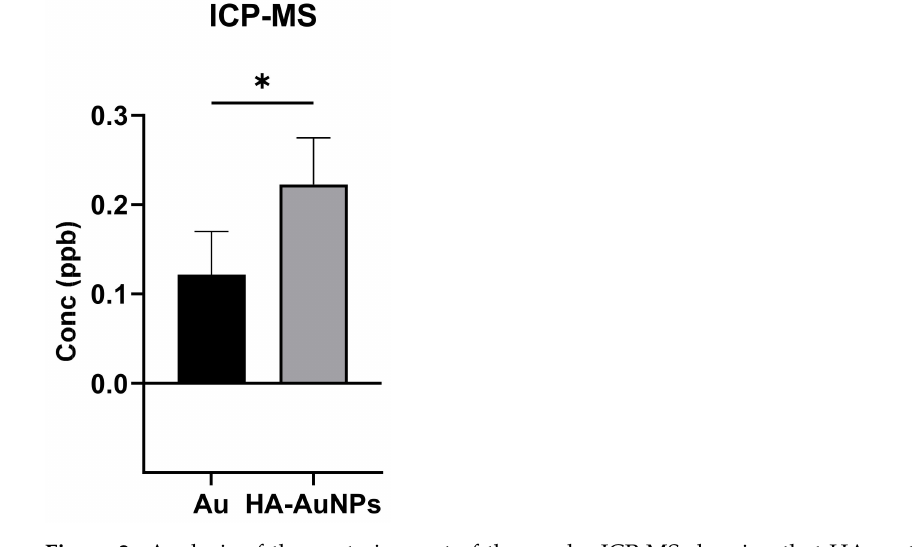
Figure 2. Analysis of the posterior part of the eye by ICP-MS showing that HA coating indeed improves NPs distribution. Statistical significance of this date is presented as * p <